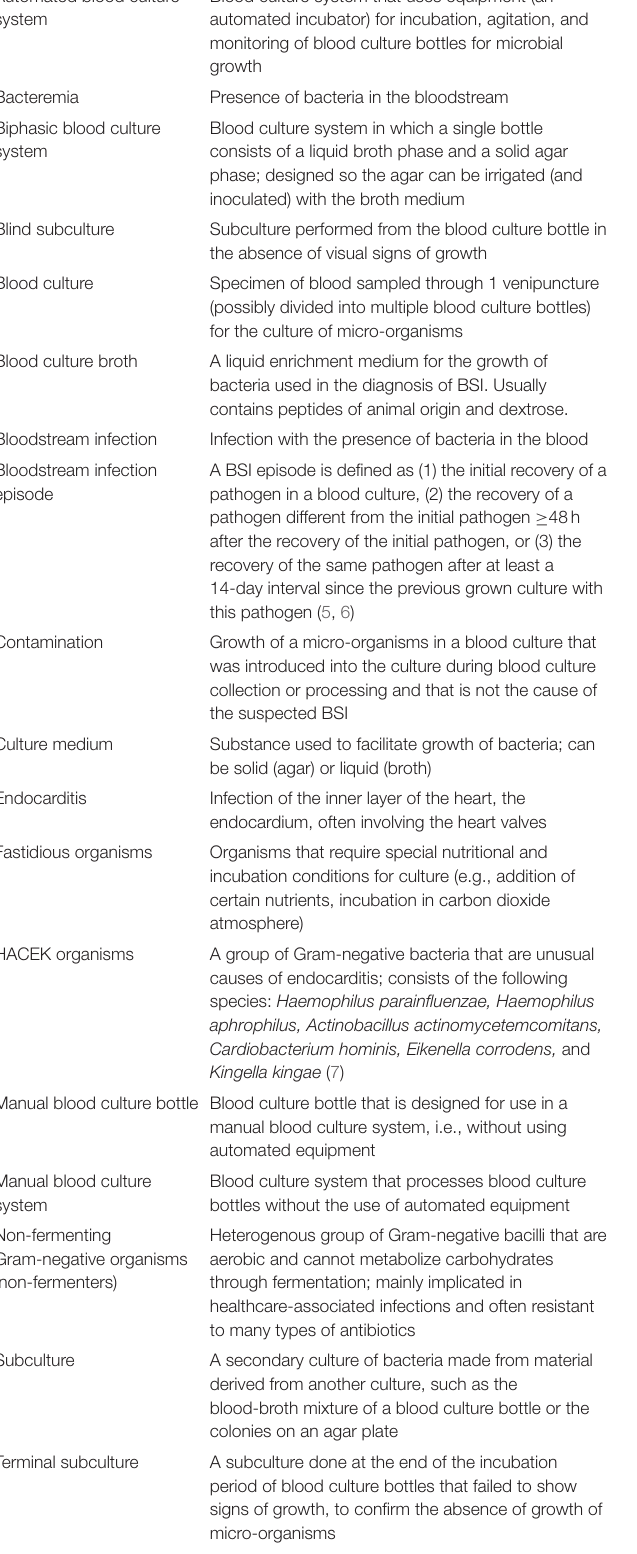
TABLE 2 | Definitions used in or related to the blood culture process. Automated blood culture Blood culture system that uses equipment (an system automated incubator) for incubation, agitation, and monitoring of blood culture bottles for microbial growth